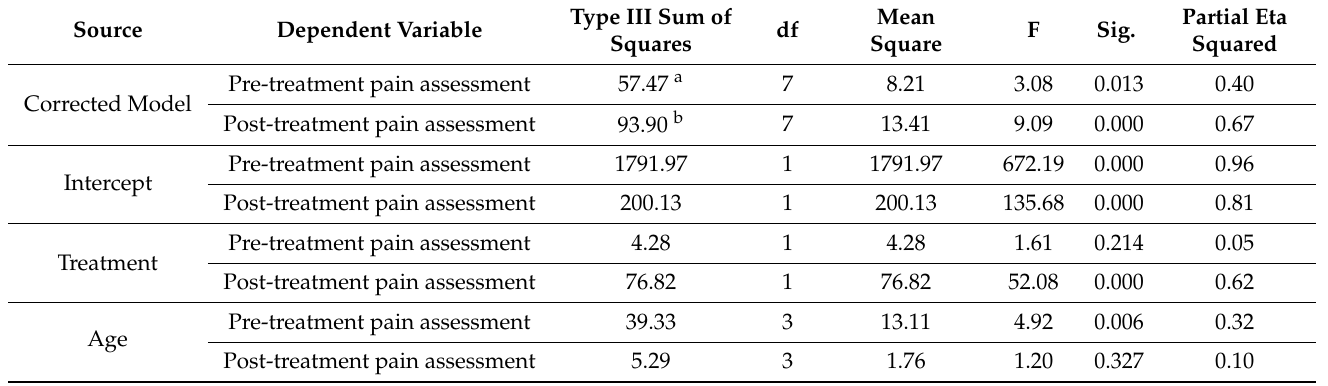
Table 3. Test of between-subjects